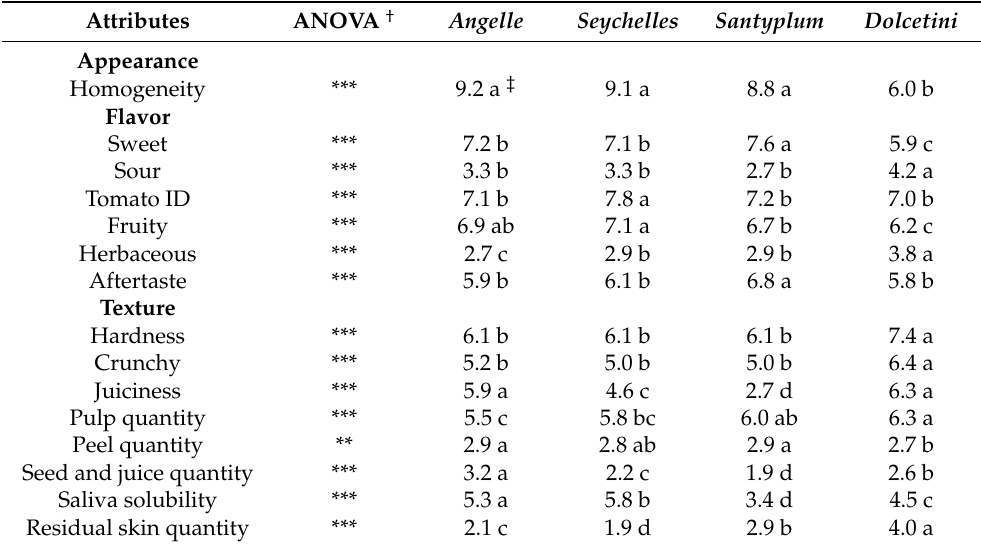
Table 4. Descriptive sensory analysis in pear cherry tomatoes as affected by